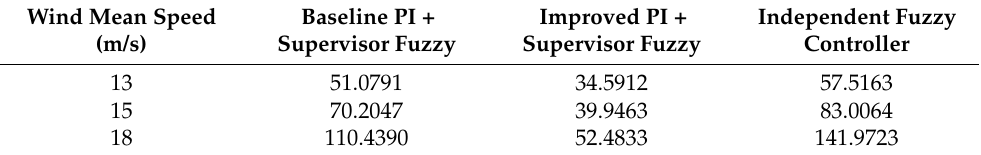
Table 4. SpI: Speed Index